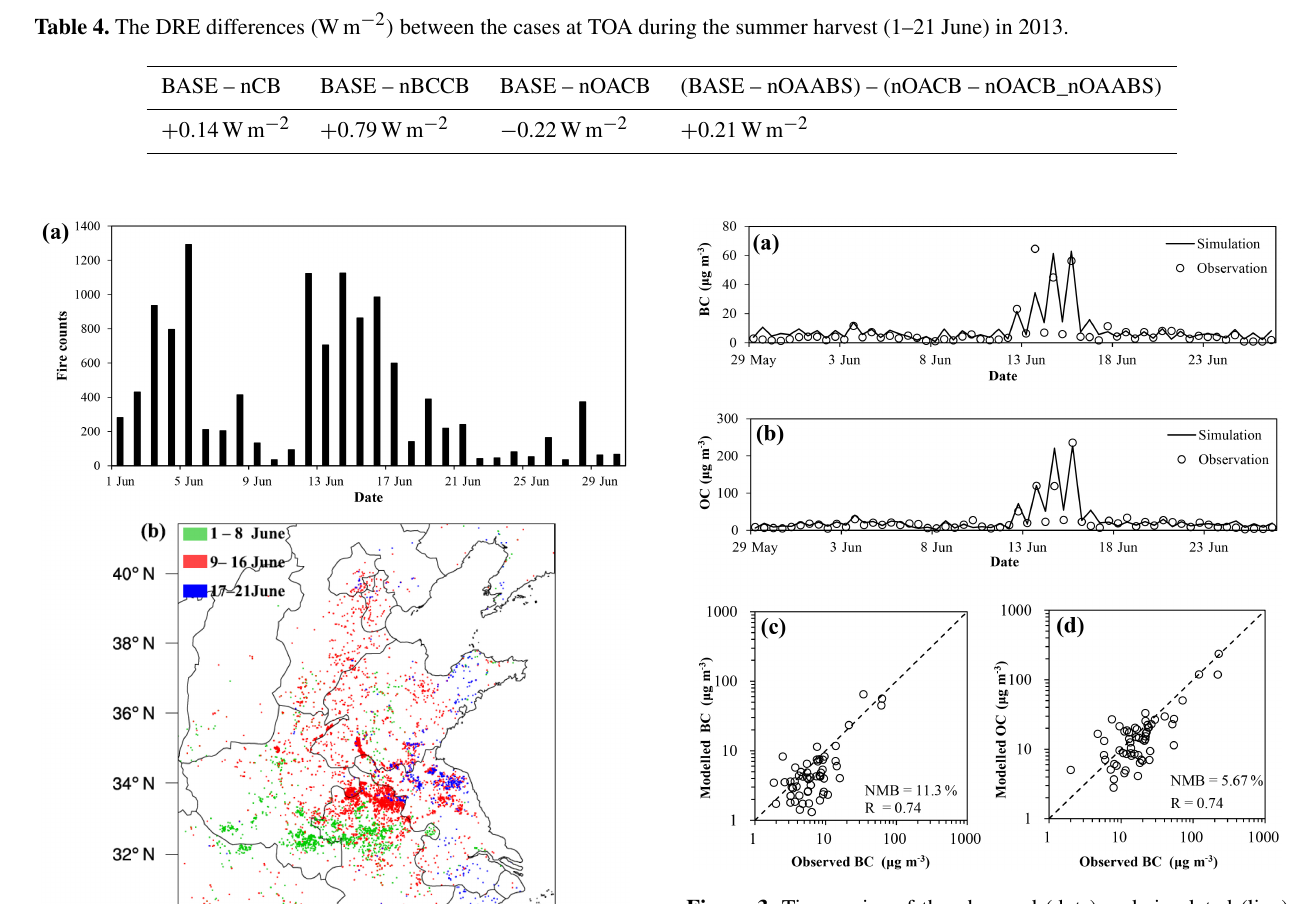
Figure 3. Time series of the observed (dots) and simulated (line) (a) black carbon (BC) and (b) organic carbon (OC) mass concen- trations (µgm − 3 ) at the Suixi site. Scatterplots of simulated (c) BC and (d) OC mass concentrations (µgm − 3 ) and the corresponding observed values. NMB and R represent normalized mean bias and correlation coefficient,